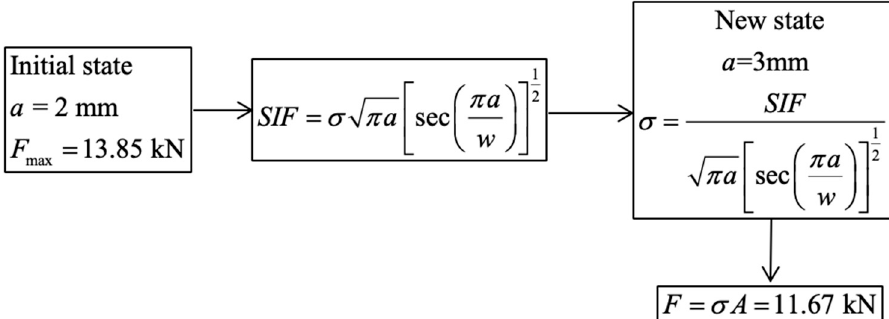
Figure 9. Block diagram for the SIF controlled fatigue experiment loading protocol. When the crack length increases by 1 mm, the new recalculated load was applied for fatigue crack growth.